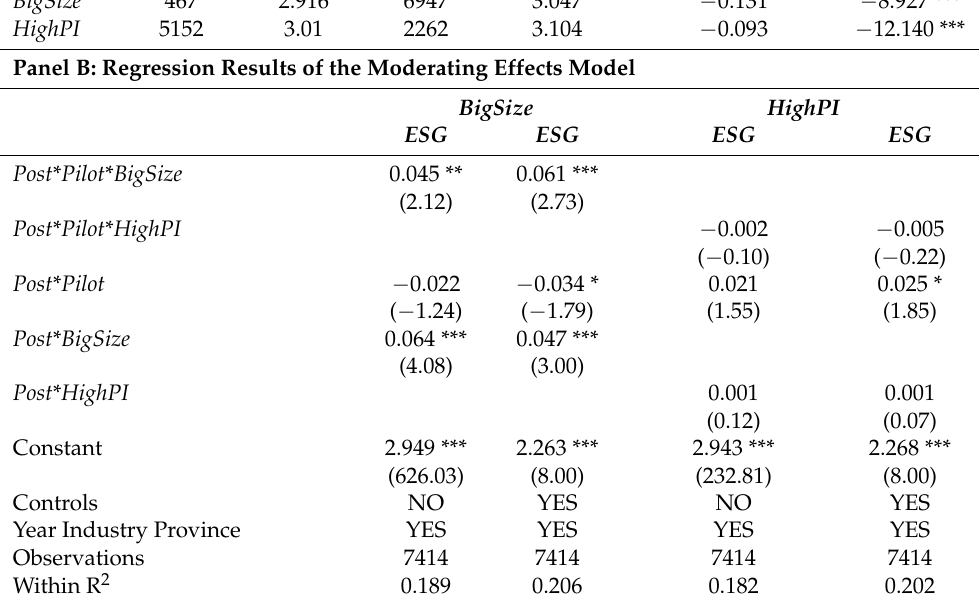
Panel B: Regression Results of the Moderating Effects